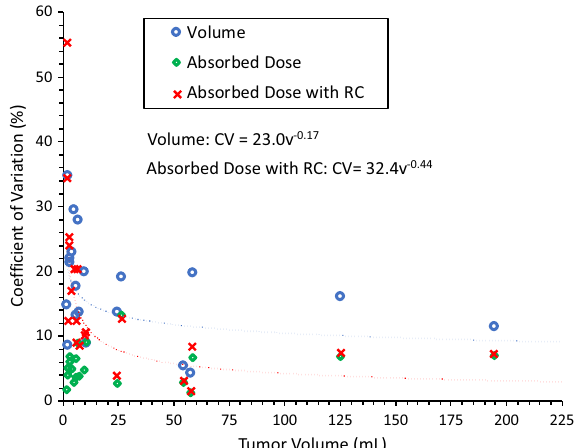
Fig. 4 Volume uncertainty and mean absorbed dose uncertainty (with and without PVC) plotted as a function of volume